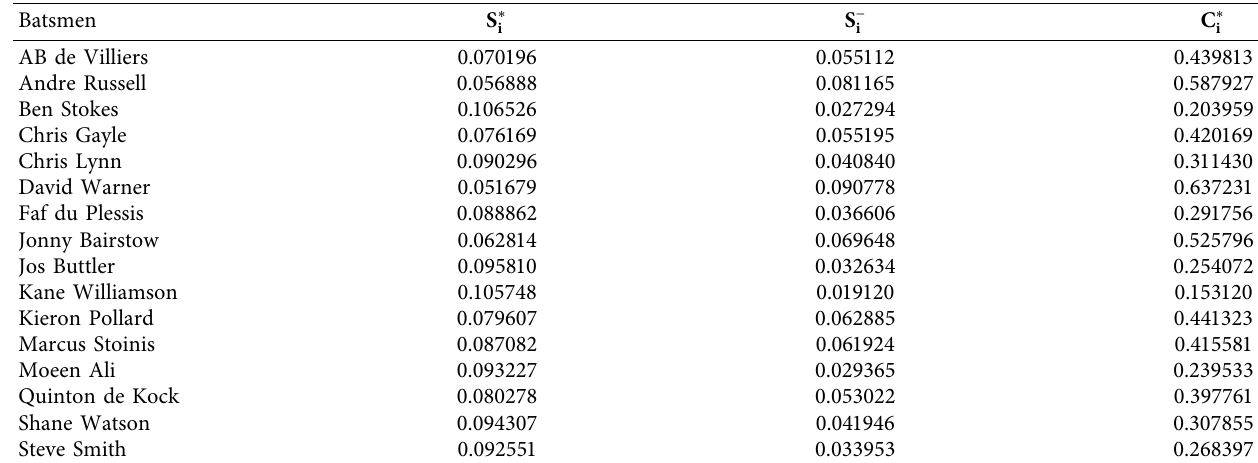
Table 5: Distance values for batsmen.